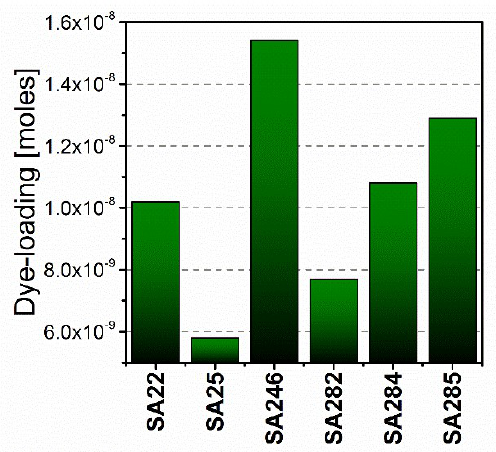
Figure 19 . Photovoltaic performance of a series of cyclometalated ruthenium complexes with Co- based electrolyte in DSCs [114].